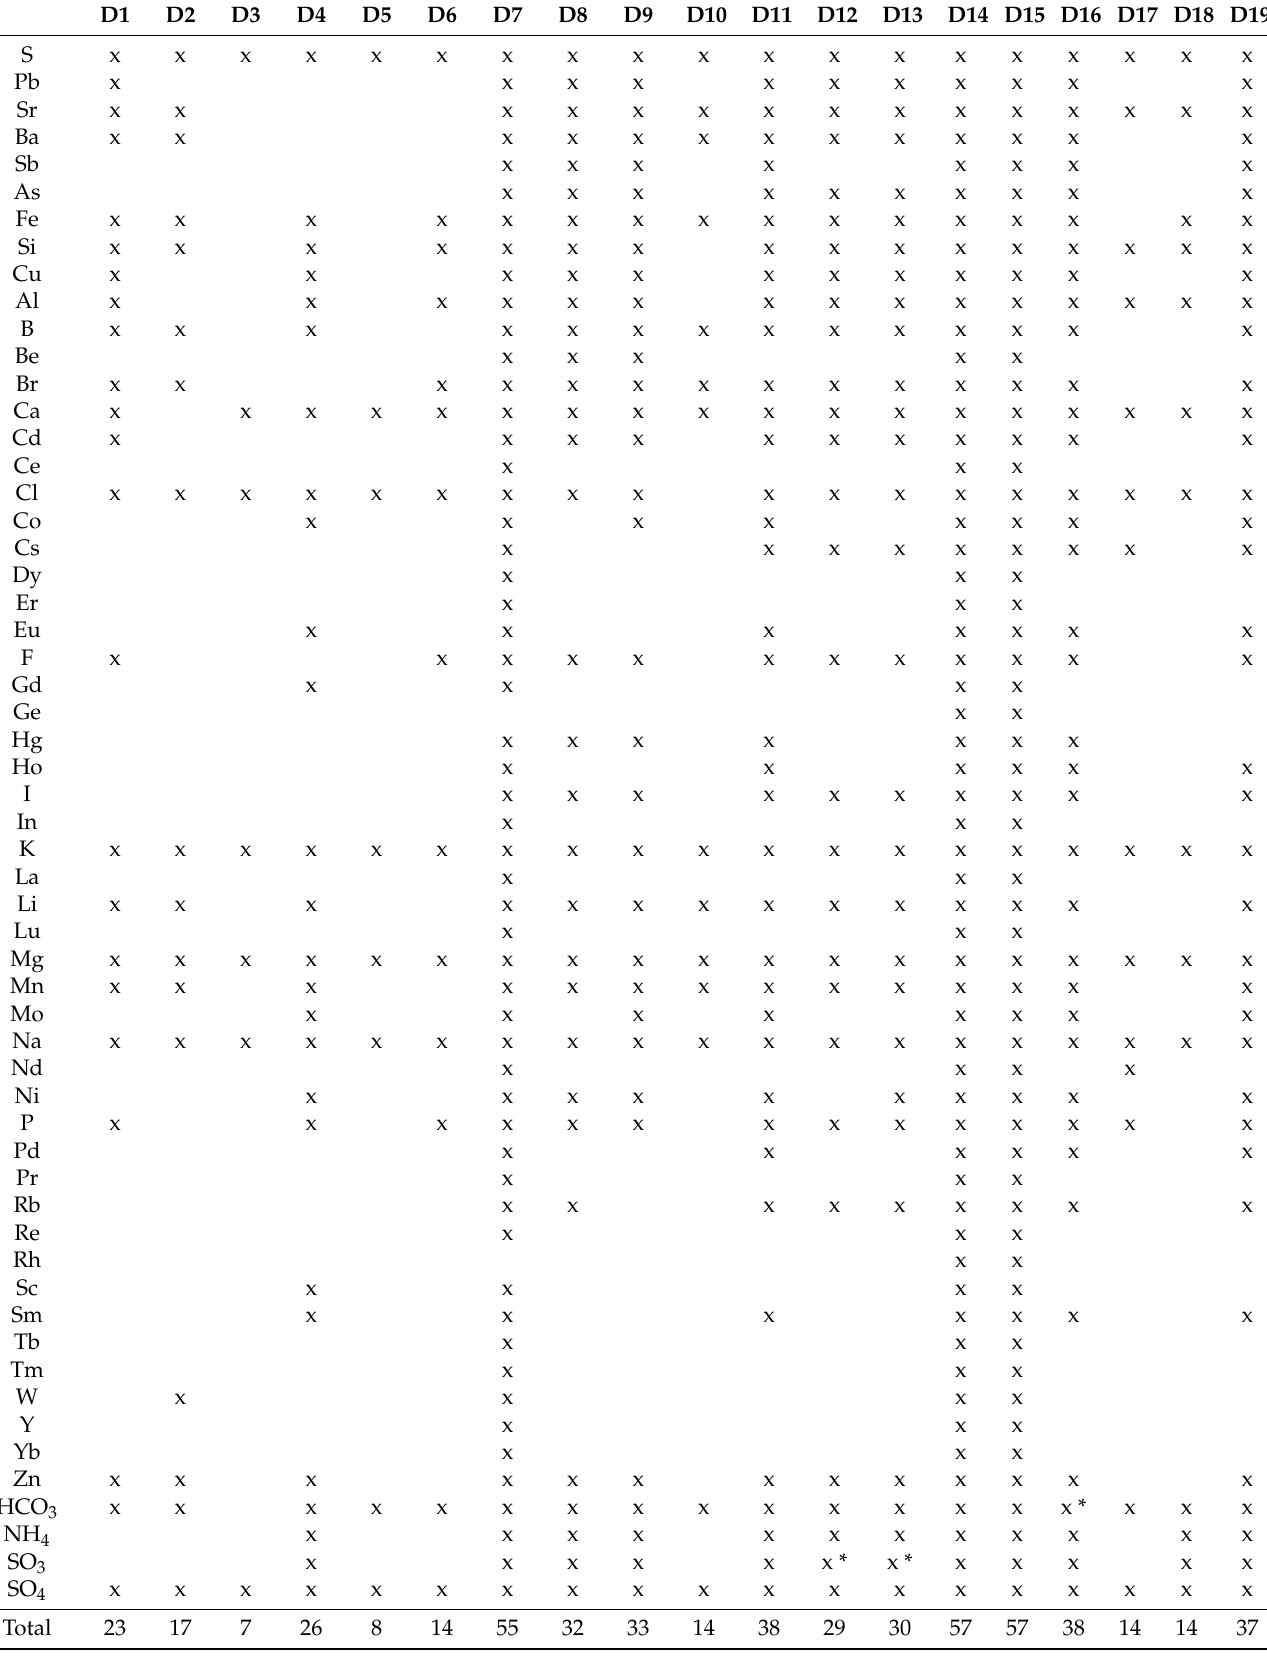
Table 5. Geochemical elements in the